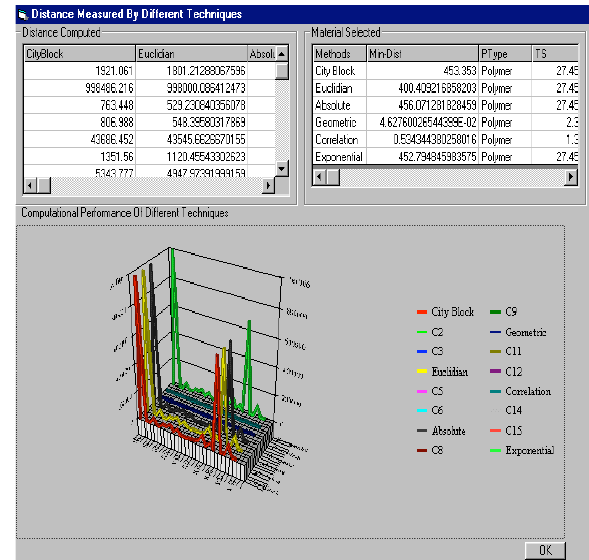
Fig. 7: Performance of evaluation of different Distance measure